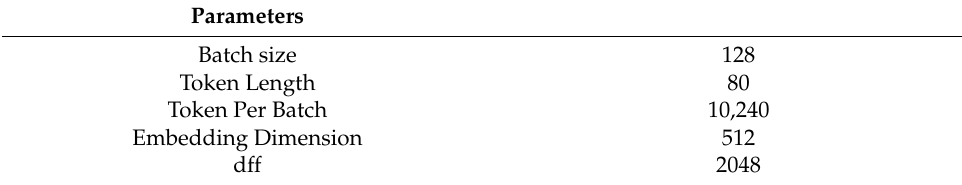
Table 3. List of Table 3. List of hyperparameters.